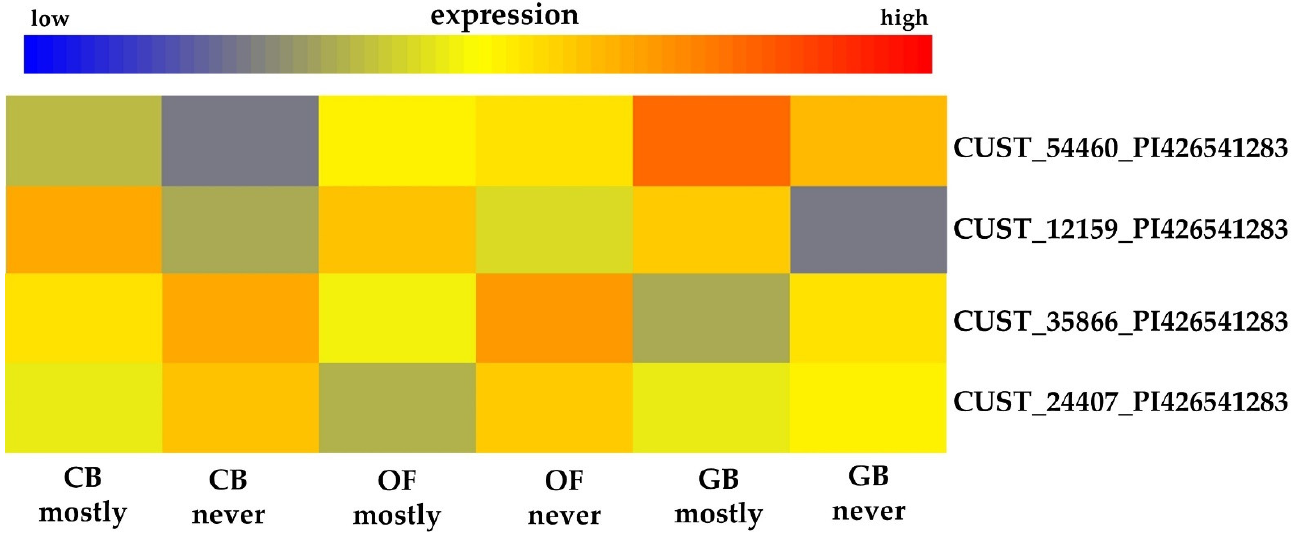
Figure 3. Tree cluster heatmaps of the five microarray probes (right end of the figure) mapped on linkage group 3 inside the crumbly QTL cr_JHI_3–15 and co-located in the fruit ripening QTLs identified by Hackett et al. [4]. The first two probes (i.e., CUST_54460_PI426541283 and CUST_12159_PI426541283) are upregulated in the mostly crumbly phenotype with the differences being statistically significant at closed bud (CB) and open flower (OF) the first probe and only at green berry (GB) stage the second probe. The third and fifth probes (i.e., CUST_37835_PI426541283 and CUST_24407_PI426541283) are downregulated in the mostly crumbly plants with differences being significant only at open flower (OF) stage while the forth probe (CUST_35866_PI426541283) is downregulated in the mostly crumbly phenotype but the difference are significant in all the three stages tested. High expression levels are indicated in red color while low expression level in blue color, as per scale bar presented.